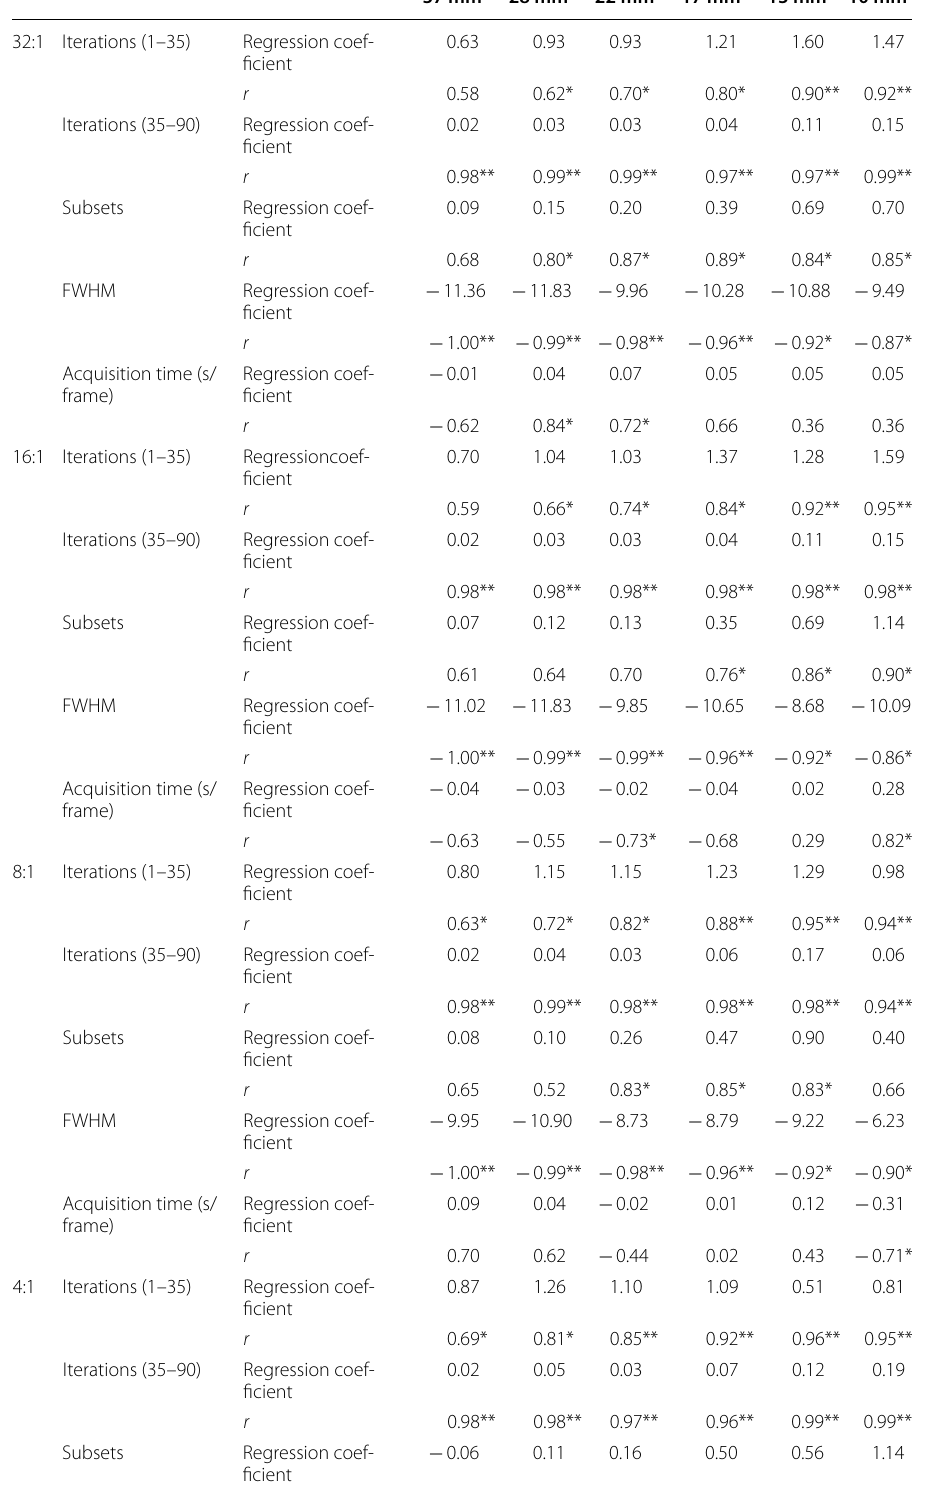
Table 1 Correlation and linear regression analysis of RCs among different acquisition and reconstruction